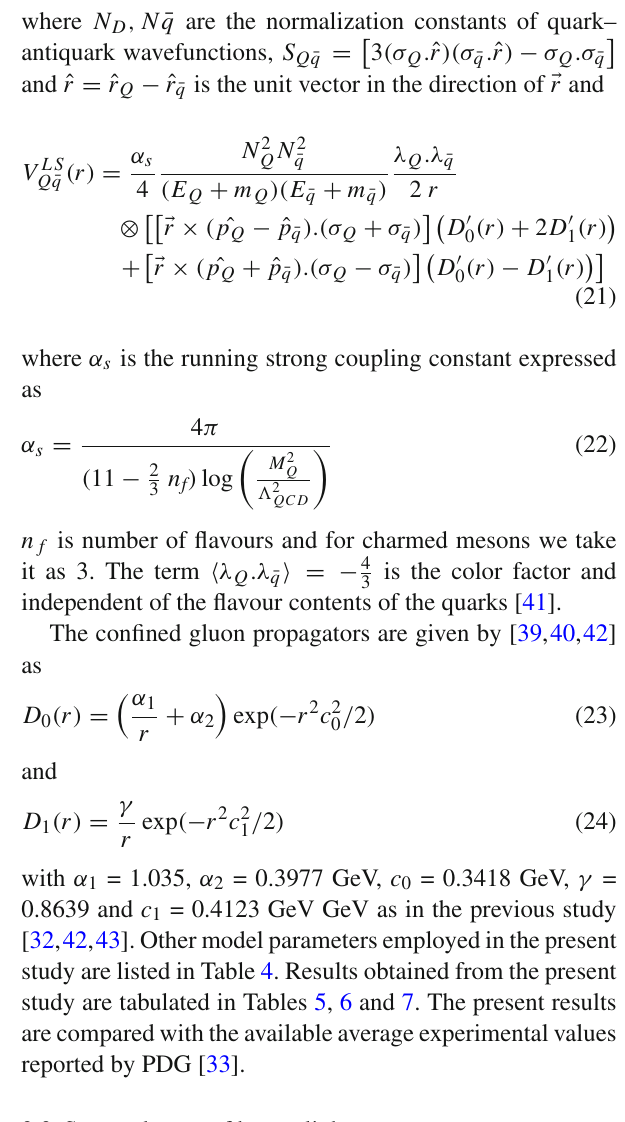
Table 4 The input parameters for the D mesons Quark mass (in GeV) m u , d = 0.003 and m c =